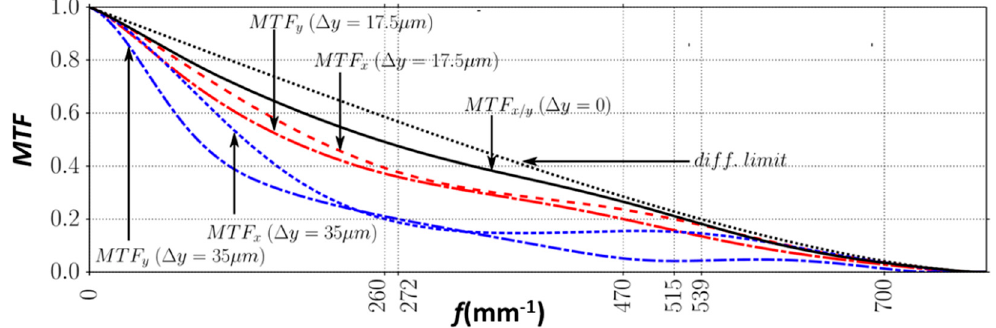
Figure 5. Modulation transfer function plotted for three situations of scan: lenses aligned on the optical axis ( Δ y = 0, black solid curve), lens scan Δ y = 17.5 µm (red curves), and Δ y = 35 µm (blue curves). MTFy and MTFx represent the MTF cross-sections along and perpendicular to the direction of the lens displacement, respectively. Reproduced with permission from [13], published by OSA Publishing, 2015.